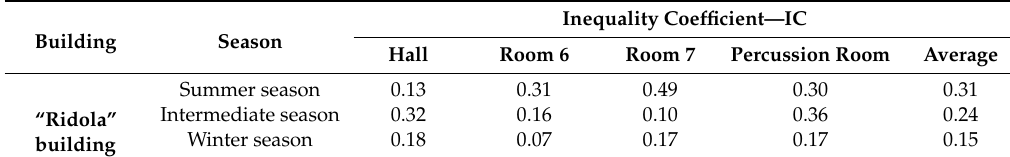
Table 7. Inequality Coefficient for the “Ridola” building.